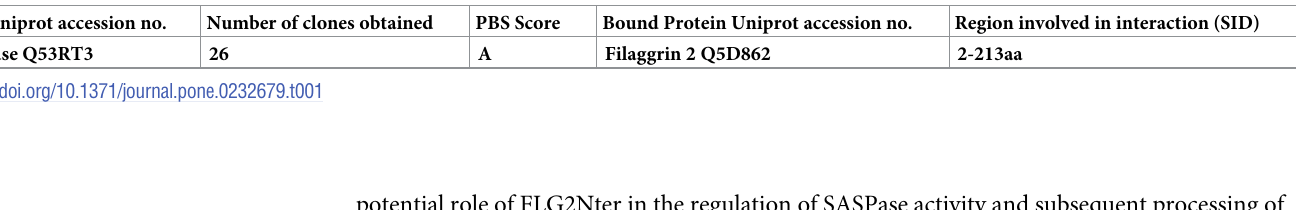
Table 1. SASPase 28 interacts with the N terminus of filaggrin 2 protein. An Y2H analysis used full length SASPase 28 as bait to screen more than 123 million clones in a random primed human reconstructed skin library. 26 out of 29 positive clones detected represented sequences from filaggrin 2 (Q5D862) with a PBS score class A and a SID domain between amino acids 2 and 213 in the N terminal domain of filaggrin 2.